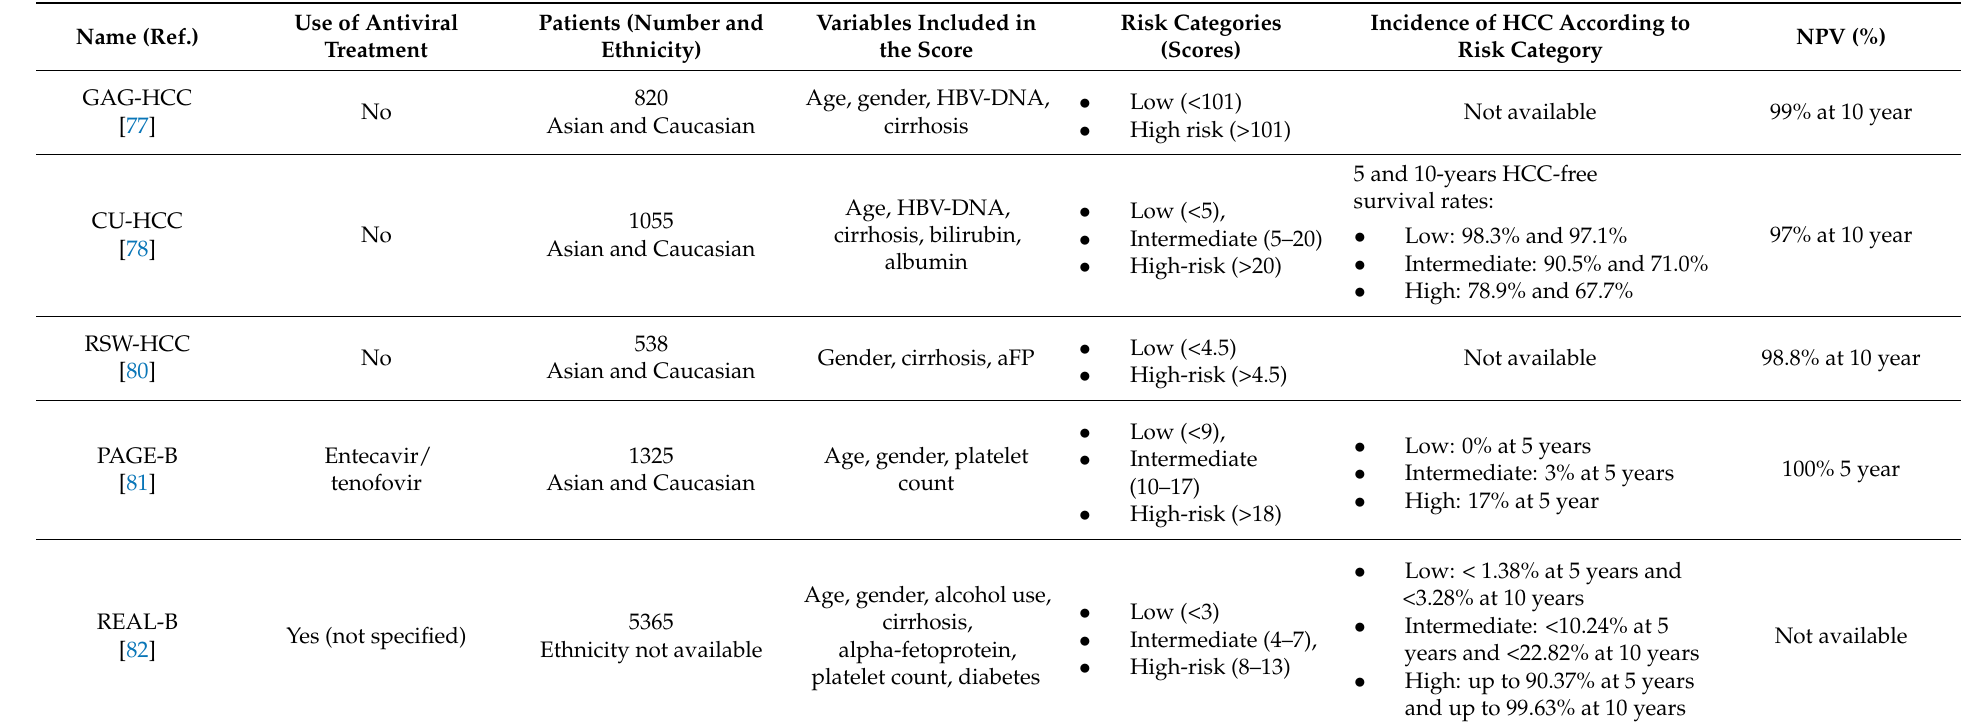
Table 2. Published scores for the evaluation of HCC risk in patients with chronic